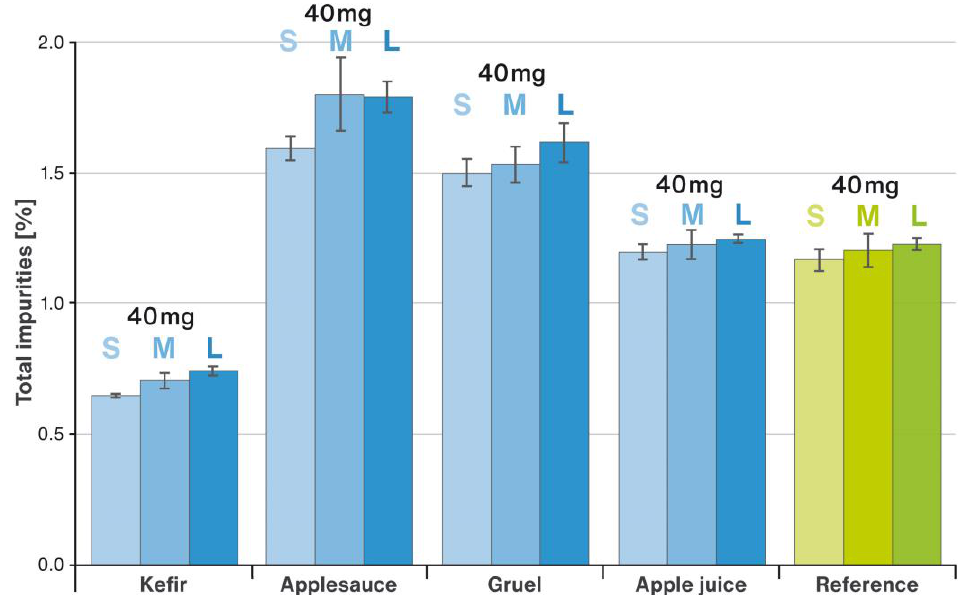
Figure 7. Comparison of the total impurities formed in the S, M, and L size RSC multiparticulates- vehicle mixture with the reference sample; mean values with n = 3; SD is indicated by error bars.